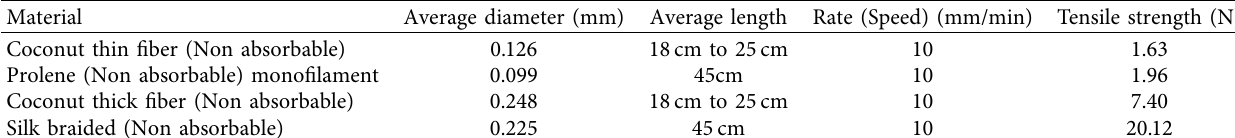
Table 1: Parameters for tensile strength estimation.